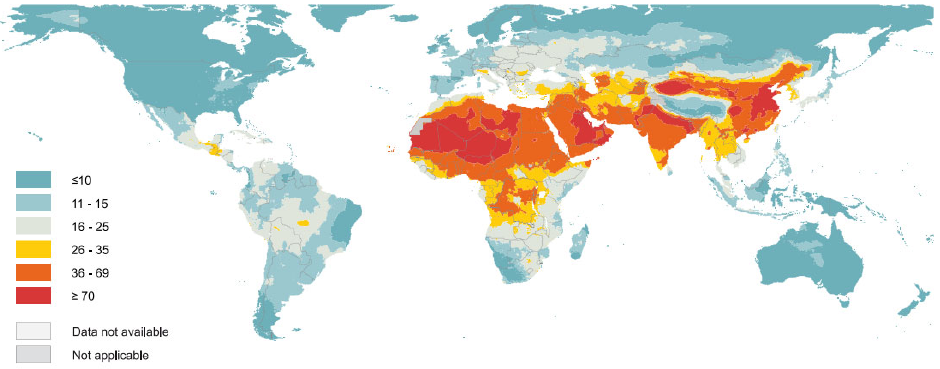
Figure 3. Modeled annual median PM2.5 concentrations, as shown on a map of the world, in µ g/m 3 Reprinted from WHO, Ambient Air Pollution: A Global Assessment of Exposure and Burden of Disease, WHO, Exposure to ambient air pollution, 33, Copyright (2022) with permission from WHO [39].